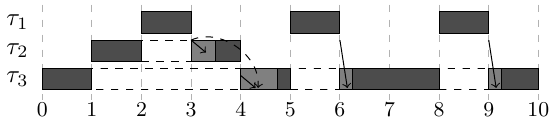
Figure 1 The pre-emption cost of all jobs of task τ 1 pre-empting task τ 2 can only contribute once to the total pre-emption cost of task τ 1 pre-empting τ 3 during the response time of τ 3 .